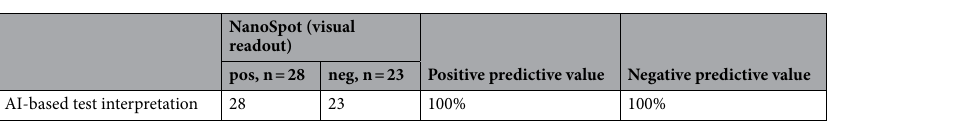
Table 2. Comparison of visual and AI-based test